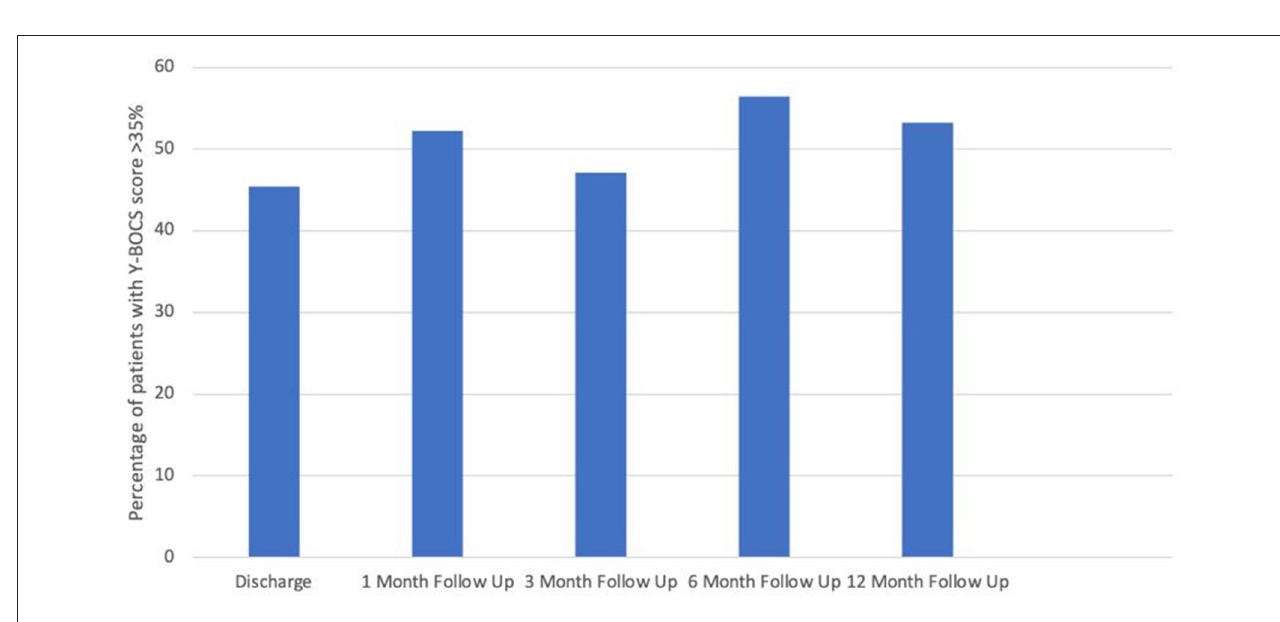
FIGURE 1 | OCD severity as indicated by the Y-BOCS total at admission, discharge, and respective follow-up points.